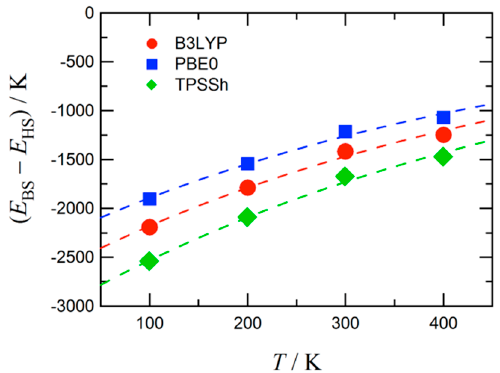
Figure 3. The energy gap between the broken symmetry singlet state ( E BS ) and quintet state ( E HS ). The functional dependence is also shown. Broken lines are drawn for a guide to the eye.